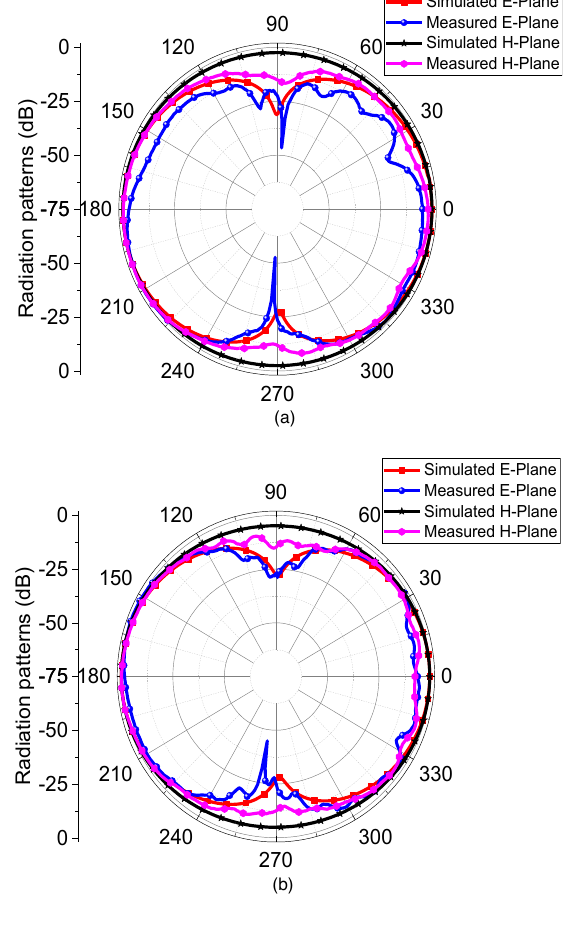
Simulated E-Plane Measured E-Plane Simulated H-Plane Measured